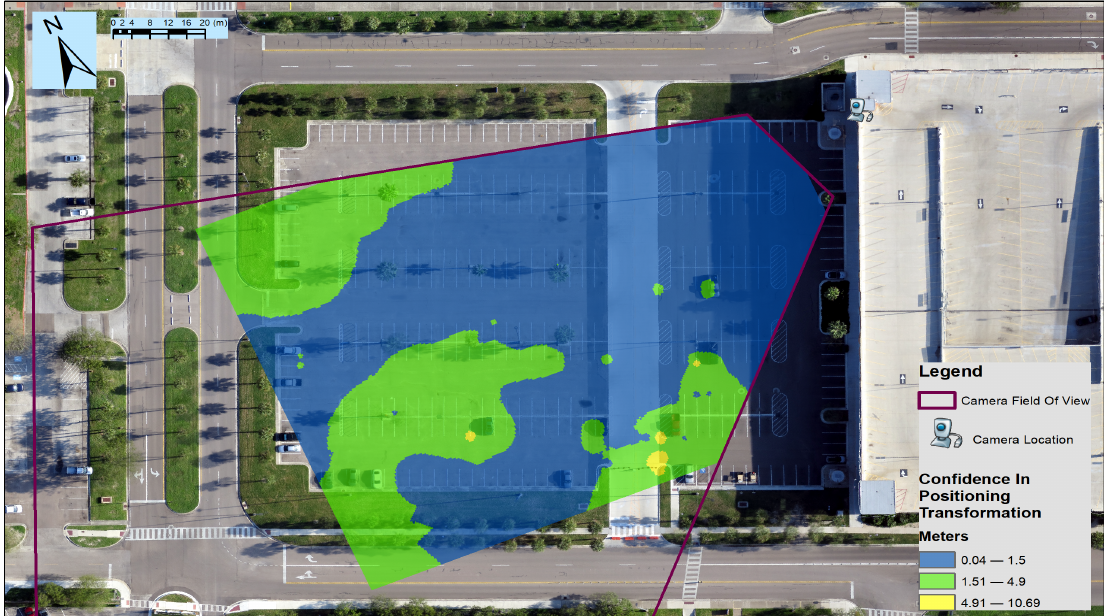
Figure 10. Transformation accuracy qualified for vehicles detected by the computer vision pipeline. Coordinates in the blue region are estimated to be accurate within the limits of the width of a small vehicle, while coordinates in the green region will be accurate to within the length of a short vehicle. Coordinates in yellow regions are likely to be outside those